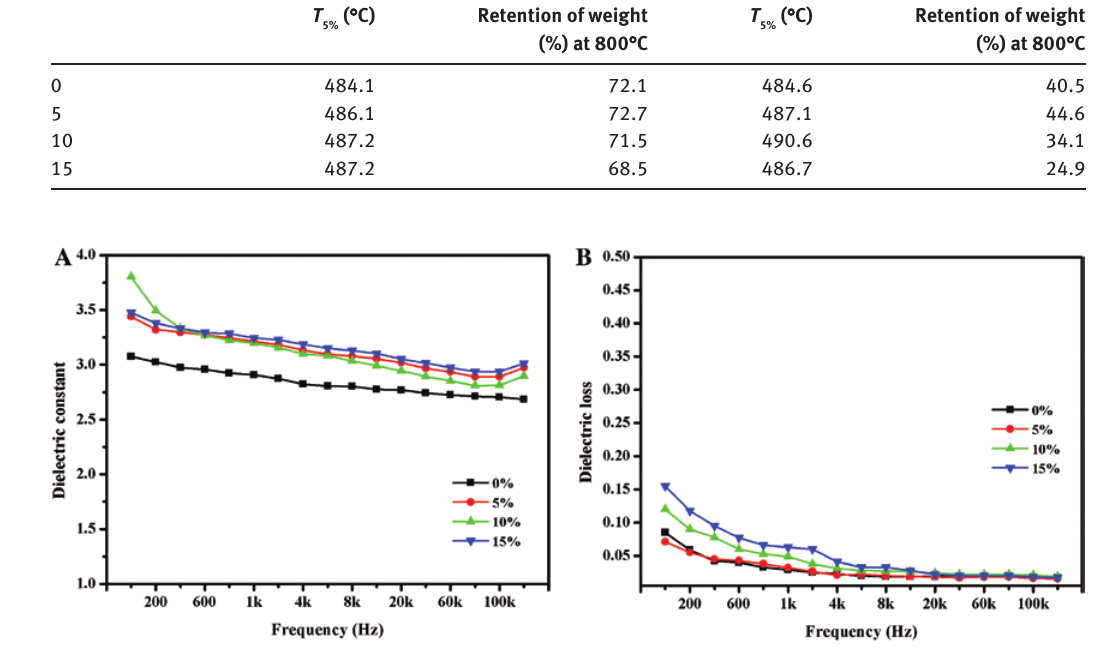
Figure 9: Influence of frequency on the (A) dielectric constant of BAPh/PEN-OH polymers and (B) dielectric loss of BAPh/PEN-OH